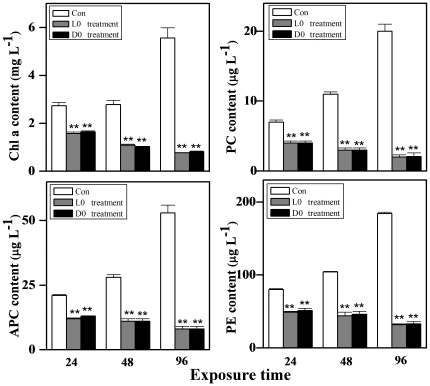
Inhibitory effects of H2O2 on Chl a, PE, PC and APC levels in M. aeruginosa for 24 h.